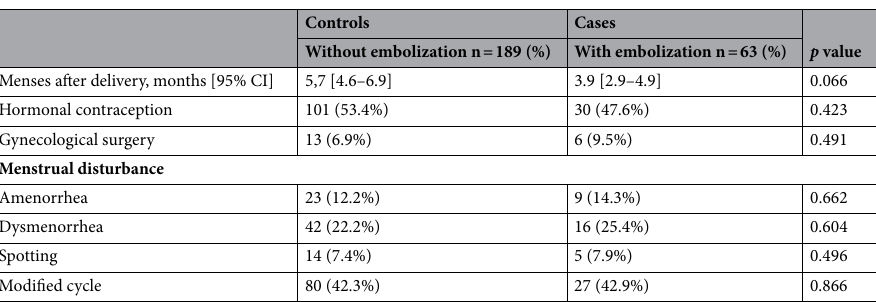
Table 2. Gynecological outcomes (95% CI; 95% confidence intervals).